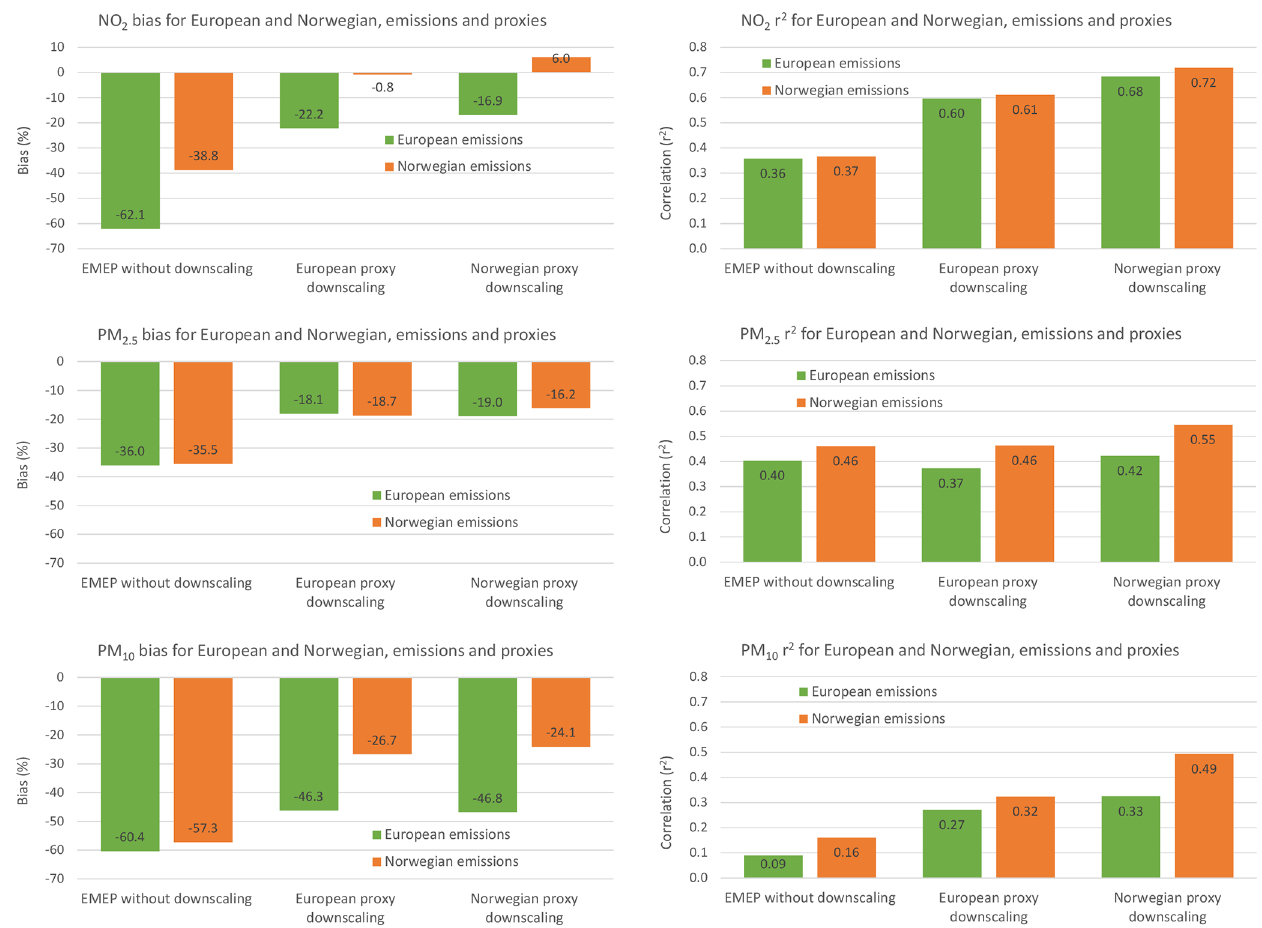
Figure 15. Change in bias and spatial correlation (coefficient of determination r 2 ) as a result of changes in Norwegian emission and emission proxy data for NO 2 , PM 2 . 5 , and PM 10 calculations. “European emissions” represents the emissions used for all of Europe, and “Norwegian emissions” replaces these emissions for traffic and residential heating with alternative emissions used in the Norwegian air quality forecasting system. “European” and “Norwegian” proxy downscaling is explained in the text. Calculation year is 2017. The number of available stations is 41, 36, and 44 for NO 2 , PM 2 . 5 , and PM 10 , respectively.